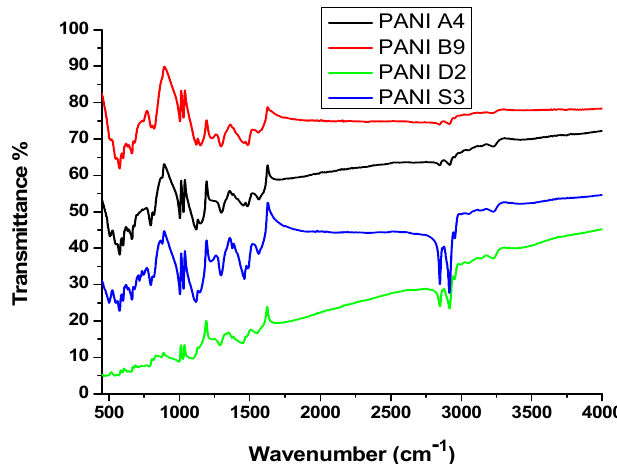
Figure 6. FTIR spectrum of different PANI samples as indicated.